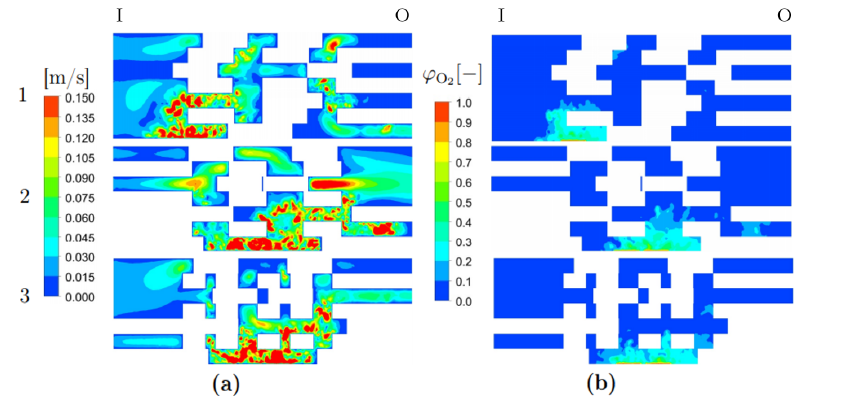
Figure 14. Distribution of ( a ) velocity of mixture and ( b ) volume fraction of O 2 of the volume-of- fluid